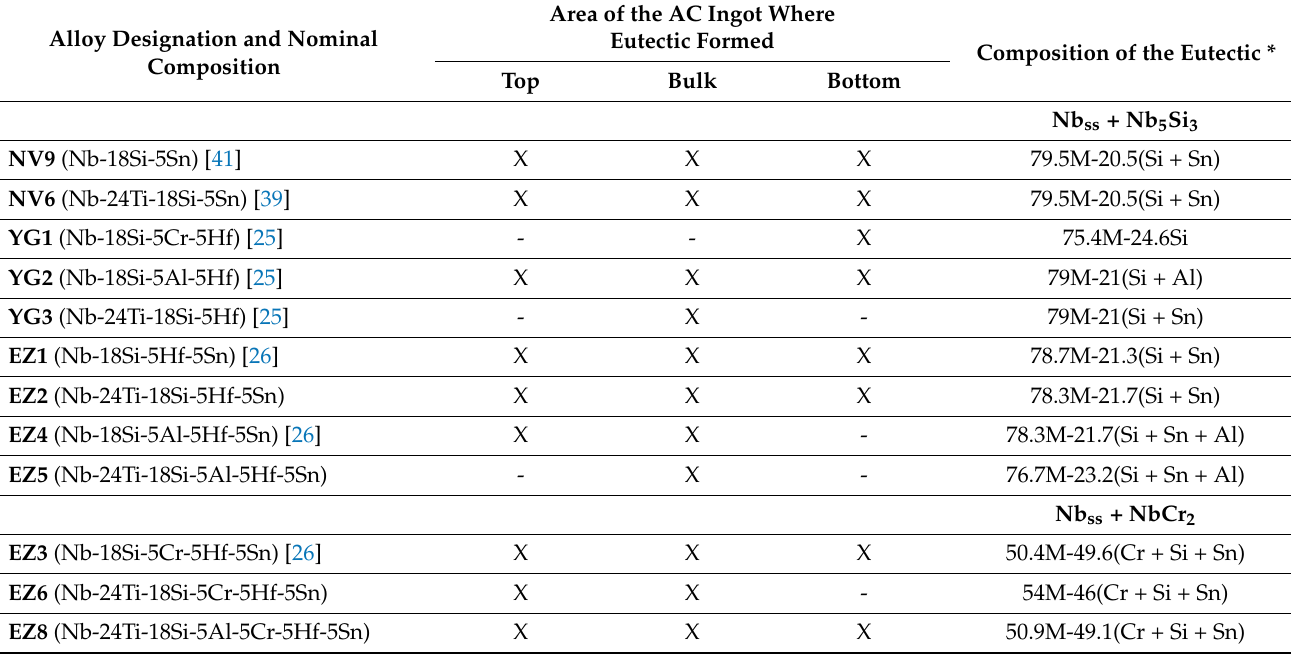
Table 7. Effect of the different alloying elements on the formation and composition (at.%) of Nb ss